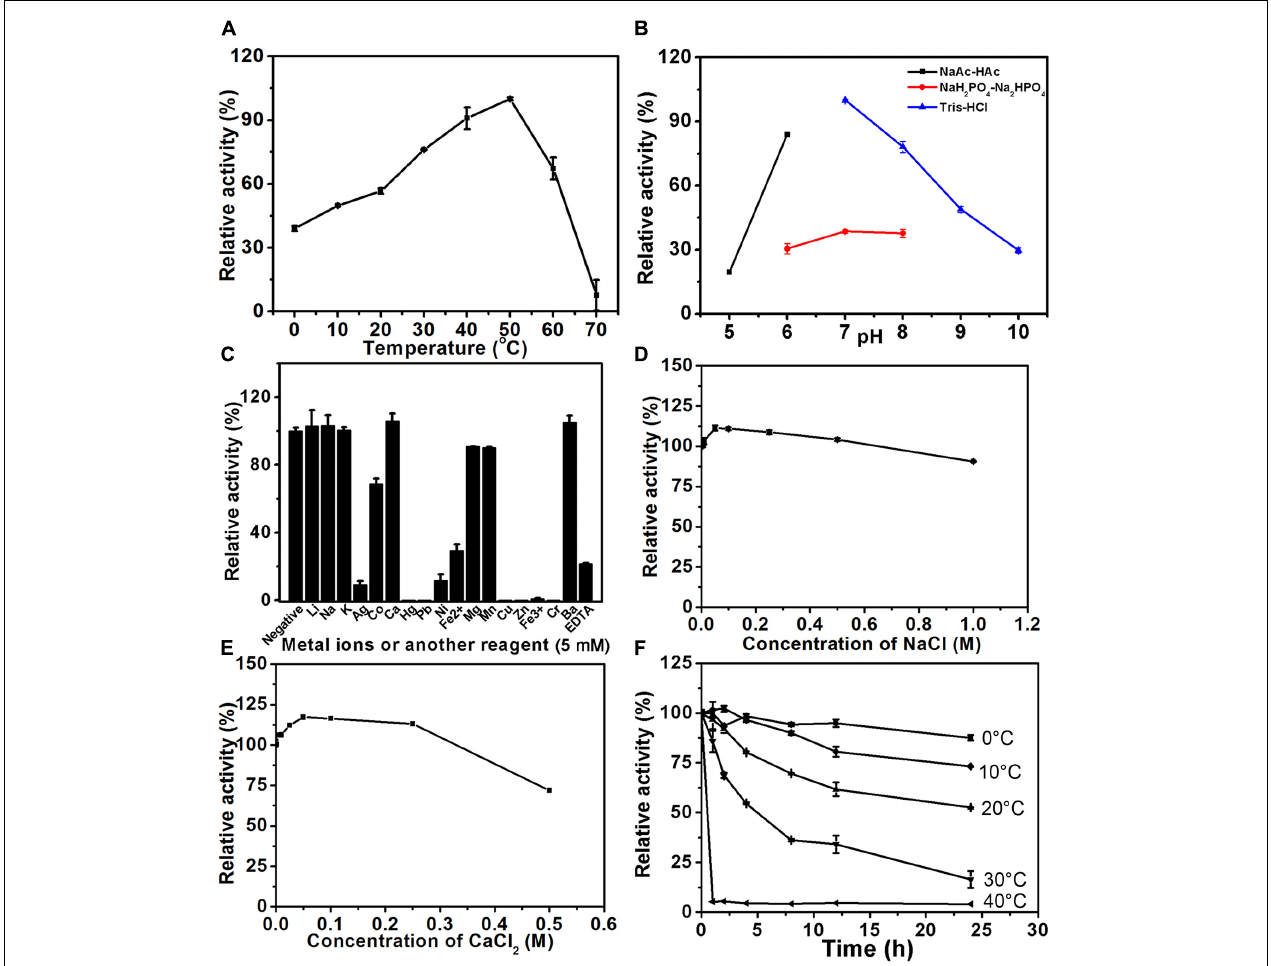
FIGURE 4 | Biochemical characteristics of PB_3262. The biochemical characteristics of PB_3262 were investigated using disaccharide (cid:49) A (1 mg/ml) as substrate as described under section “Materials and Methods.” (A) The effects of temperature on the activity of PB_3262 were determined at 0–70 ◦ C and the activities were presented as relative values calculated by comparing with the highest (100%) obtained at 50 ◦ C. (B) The effects of pH were determined in buffers (NaAc-HAc buffer, NaH 2 PO 4 -Na 2 HPO 4 buffer and Tris-HCl buffer) with different pH values from 5 to 10 and the activities were presented as relative values calculated by comparing with the highest obtained in the 50 mM Tris-HCl buffer (pH 7.0). (C) The effects of metal cations were measured in Tris-HCl buffer (pH 7.0) containing 5 mM various metal ions and the activities were presented as relative values calculated by comparing with the highest obtained in Tris-HCl buffer (pH 7.0) only. (D) The thermostability of PB_3262 was estimated by preincubating this enzyme in 50 mM Tris-HCl buffer (pH 7.0) at temperatures from 0 to 70 ◦ C for 0–24 h followed by measuring residual activities. (E) The effects of Na + concentration on the activity of PB_3262 were assayed in Tris-HCl buffer (pH 7.0) containing 0–1 M NaCl and the activities were presented as relative values calculated by comparing with that obtained in the buffer without Na + . (F) The effects of Ca 2 + concentration were measured in Tris-HCl buffer (pH 7.0) containing 0–0.5 M CaCl 2 and the activities were presented as relative values calculated by comparing with that obtained in the buffer without Ca 2 + . Error bars represent means of duplicates ±